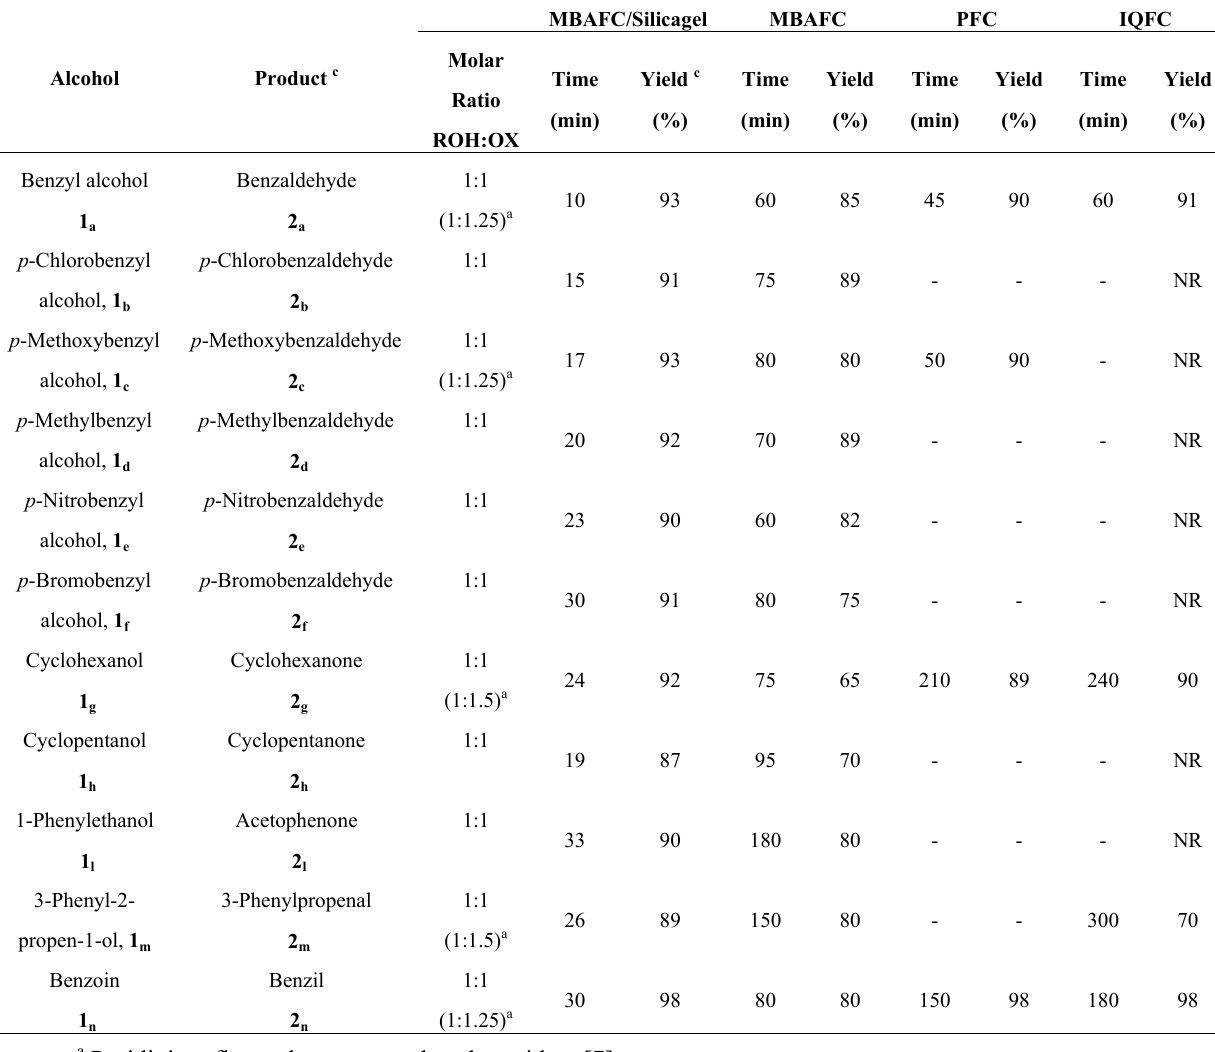
Table 1: Oxidations via MBAFC/Silica gel, MBAFC, PFC a and IQFC b